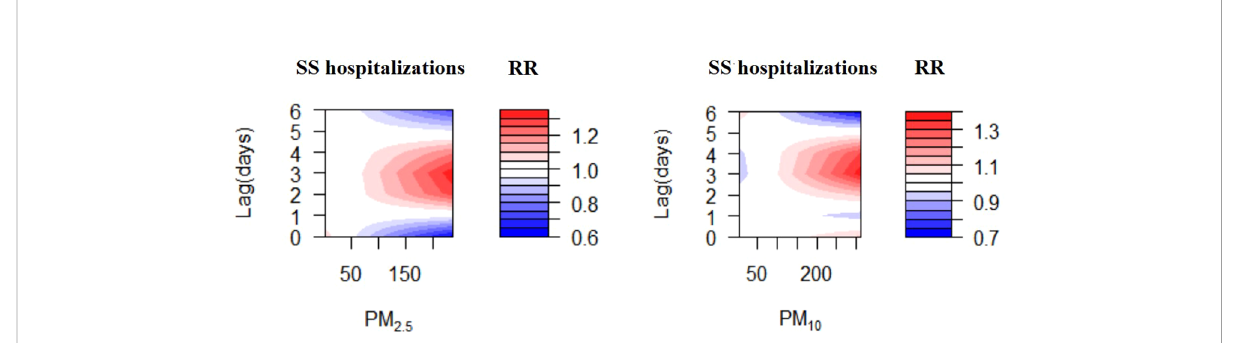
FIGURE 3 Contour plots for relative risk of hospitalizations for SS along PM2.5, PM10 at lag periods.